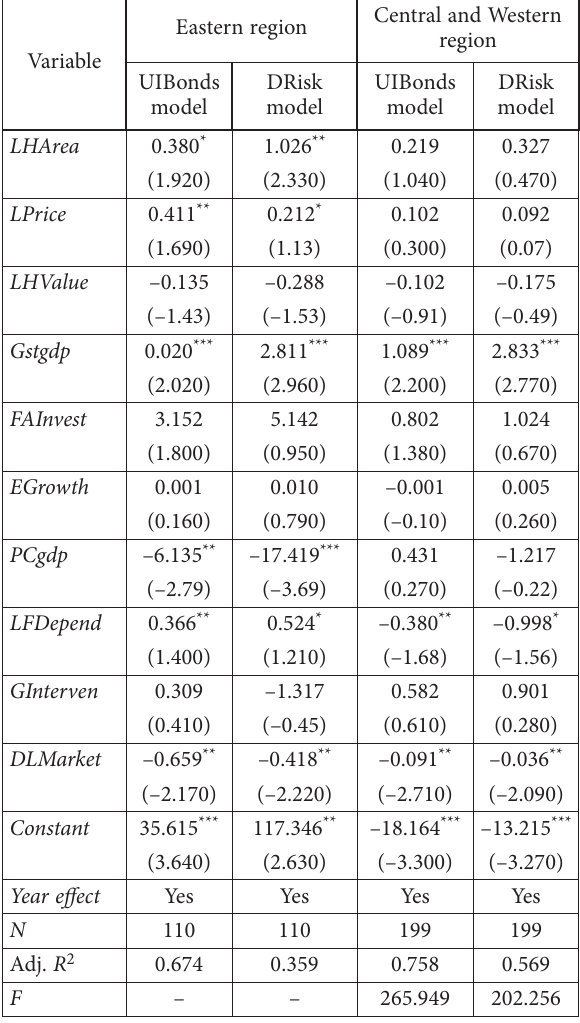
Table 6. Estimation results of Eastern and Central